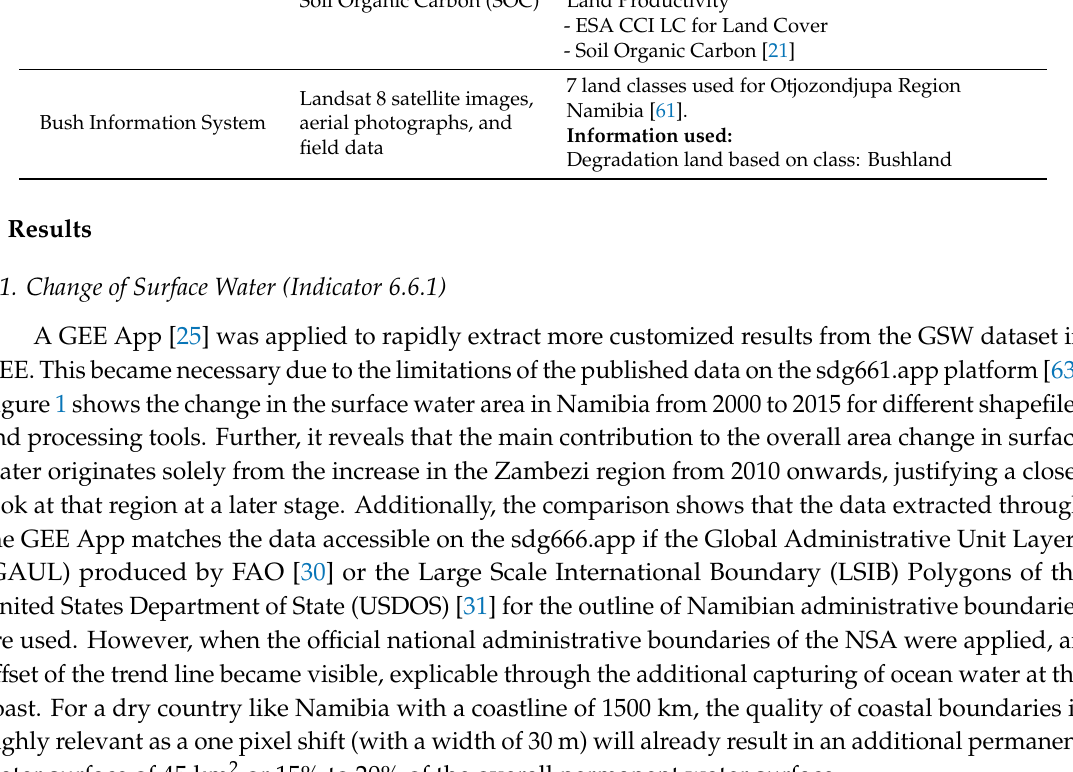
Figure 2. Comparison Boundaries of the United States Department of State Large Scale International Boundary (USDOS LSIB) vs. the Namibia Statistics Agency (NSA) shapefile at Walvis Bay (Erongo Region). To assess the accuracy of the GSW dataset, it was compared to the NDWI [28], derived from Sentinel-Hub to evaluate if and how three typical small and large scale water bodies in Namibia are detected. Figure 3 shows the extent of water at Hardap Dam in September 2015. It can be seen that the GSW dataset does not detect all water at the edges of the dam as permanent water in the NDWI layer (NDWI > 0.5 [33]) from imagery from 22nd of September 2015 indicates.